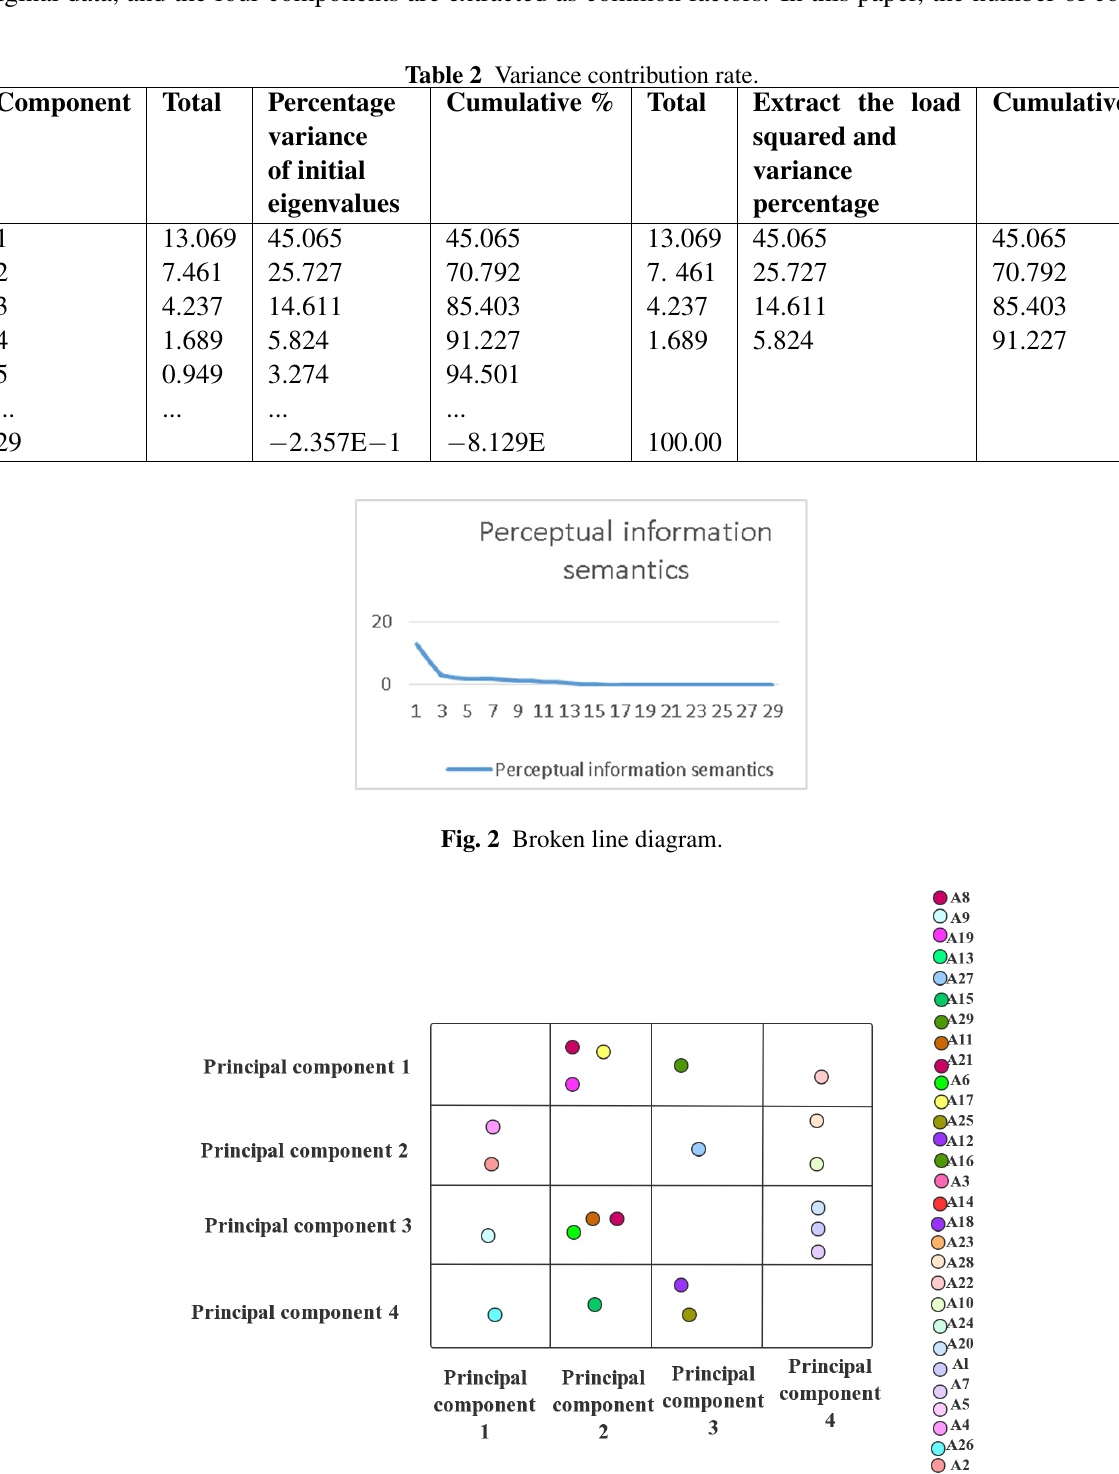
Fig. 3 Two-dimensional distribution matrix of scatter of perceptual